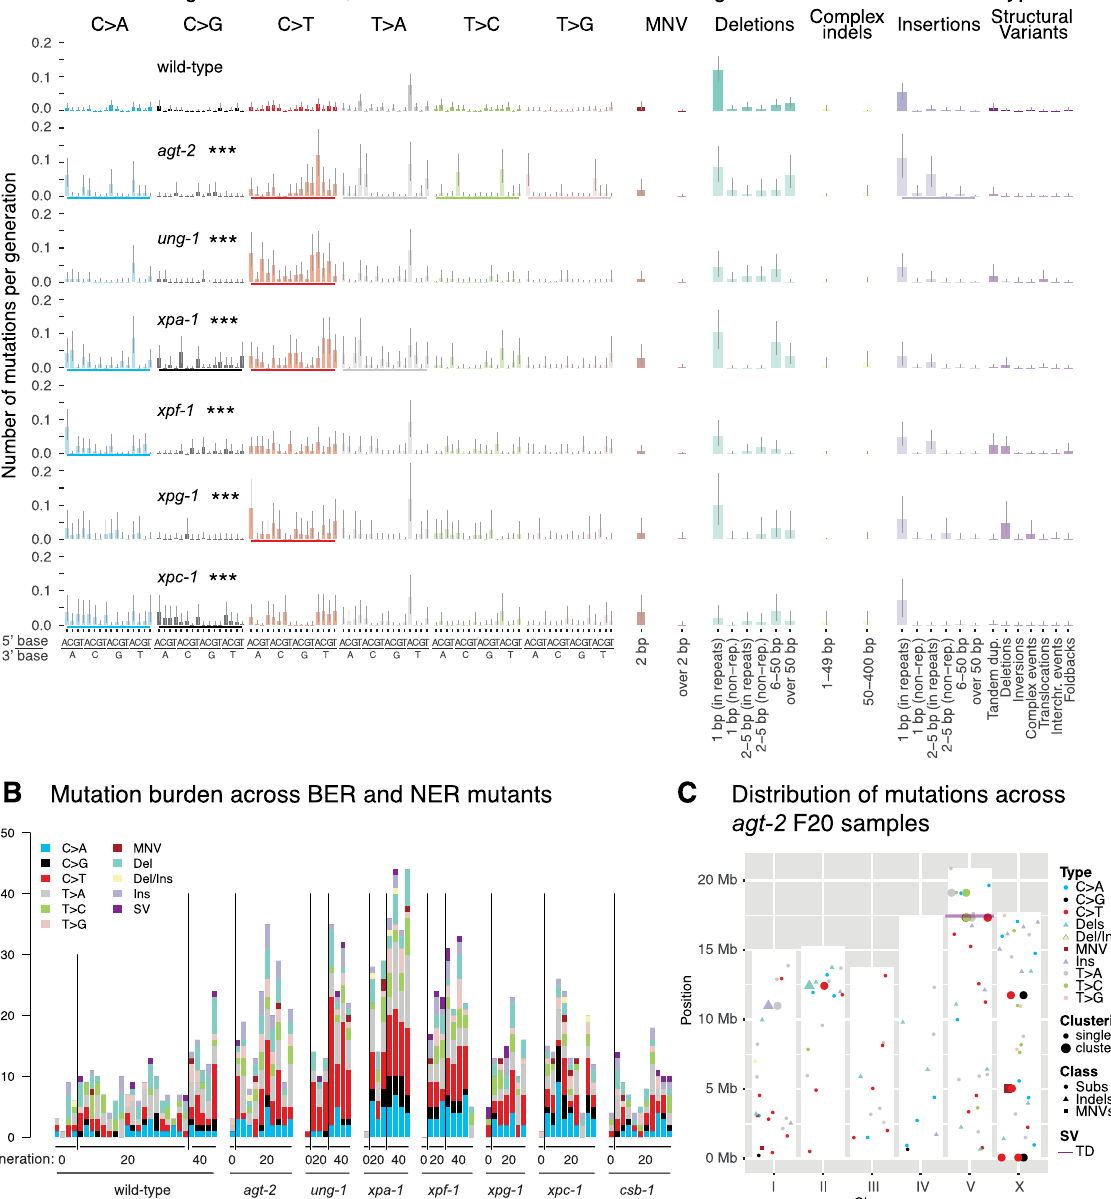
Fig 3. Mutation analysis of C . elegans BER, NER, and DR mutants with mutation rates or spectra different from wild-type. A. Mutational signatures of BER, NER, and DR mutants that display statistically significantly different mutation spectra than wild-type shown as the number of mutations per generation across all mutation classes. Underscores (bold coloured bars) below each mutation profile indicate mutation types where the total mutation numbers are different from wild-type, three stars indicate genotypes with significantly different rates of substitutions, indels or SVs compared to those in wild-type (FDR < 5%). Single nucleotide variants are shown in the context of their 5’ and 3’ base context. B. Number of mutations of all classes shown for each individual sequenced line of the indicated genotype and generation. The four sequenced wild-type P0 lines reflect the variance present in initial generations. Mutations are shown cumulatively with mutations present in generation F20 included in F40. C. Mutation types of all classes and their location on the 6 C . elegans chromosomes (I-V and X) observed across agt-2 mutant lines. The height of the white bars corresponds to the length of each individual chromosome. Single nucleotide variants (SNVs) are indicated by a dot, dinucleotide variants (DNVs) by a square, indels divided in deletions (D), insertions (I), and deletions with insertions (DI) by a triangle, and structural variants (SVs) by a line. Clustered mutations that are present within a single agt-2 line are depicted by enlarged bold symbols. An analysis of brca-1 , him-6 and smc-6 swas previously shown in ([10] Fig 1C). Information related to the 528 whole genome sequencing WGS primary-source datasets (56 deposited in this study, 472 deposited in (Suppl Data 1 and Supple Note 1 of [10] can be found in S1 Table).